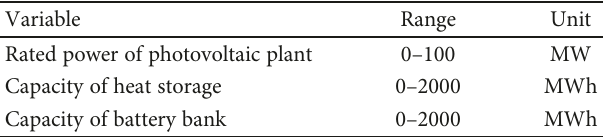
Table 6: Optimization design variables and range.